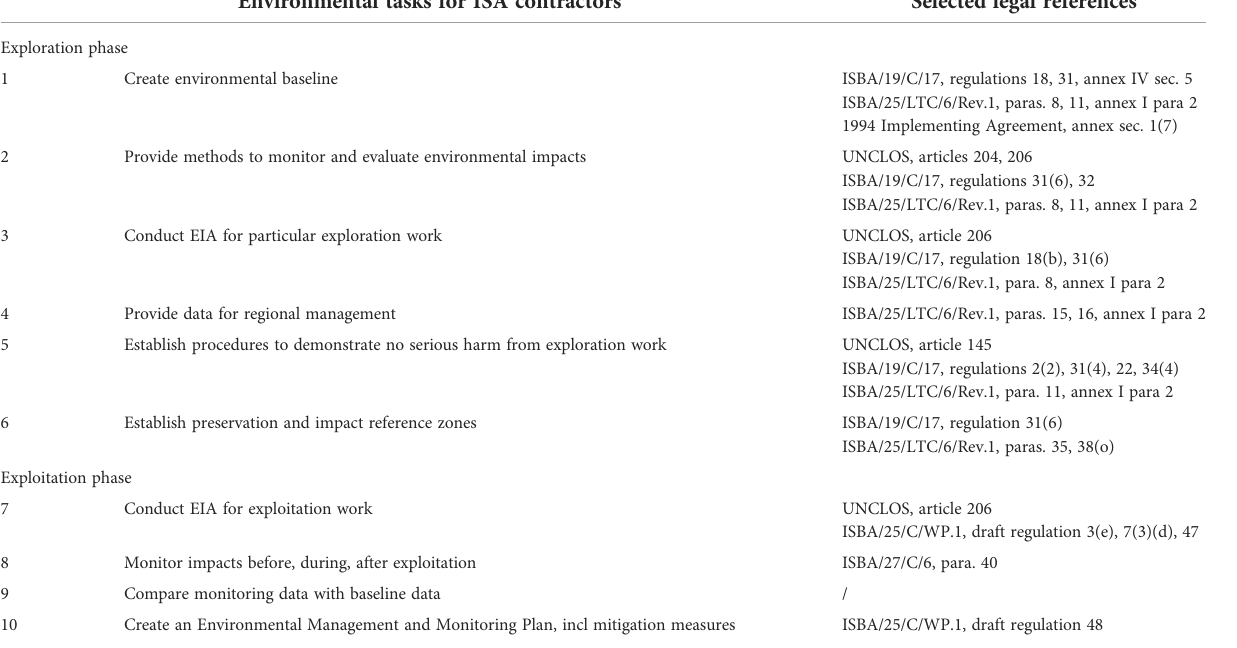
TABLE 1 Selected environmental tasks and requirements involved in DSM and selected corresponding legal